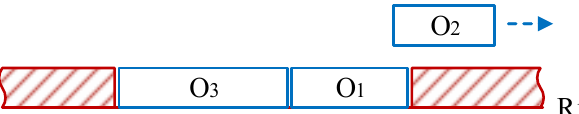
Table 7. The change of agent budgets in transition between states.